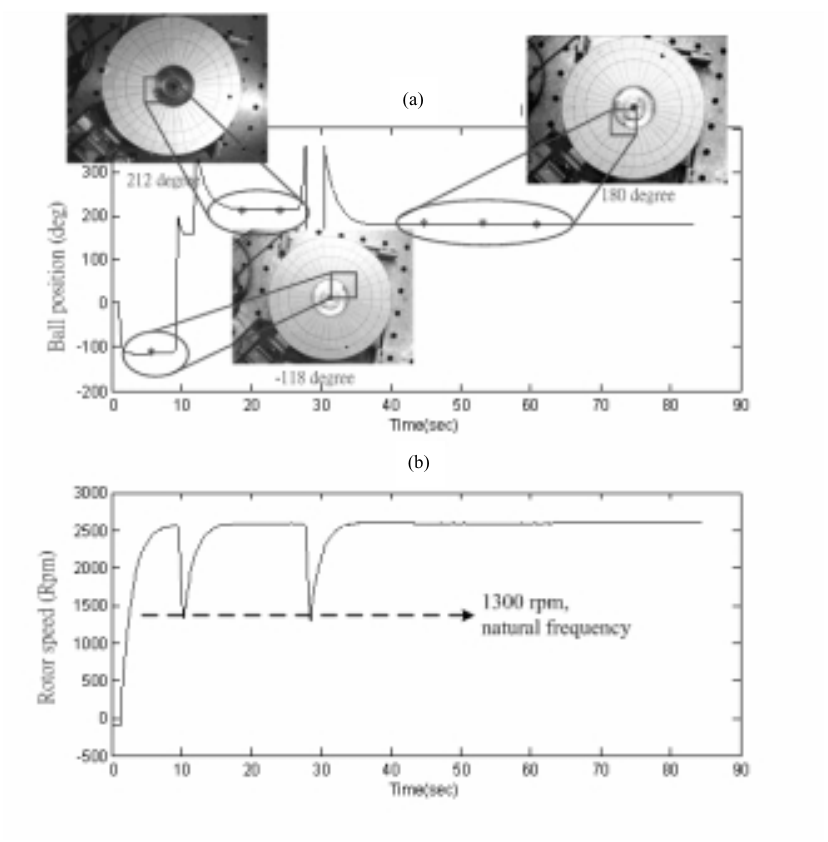
Fig. 15. Experimental results by the ball re-positioning scheme with operation speed 2600 rpm, experiencing two trials of speed drops. (a) Ball position versus time and the corresponding pictures, where the solid line, “–”, represents the observed results and the stars, “*”, denotes the actual ball positions. (b) The rotating speed of spindle motor versus